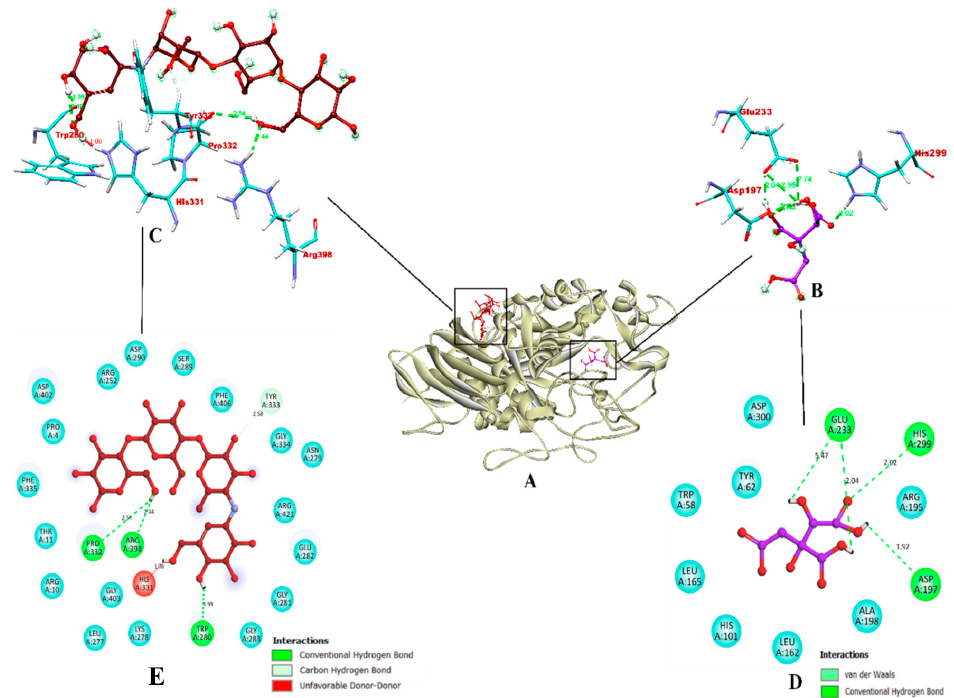
Figure 9. The binding interactions of hydroxyacetic acid and acarbose within the inhibitor binding site of target protein α -amylase. ( A ) Ribbon representation of a protein model bound with the ligands (inside the binding site); ( B , C ) Three-dimensional binding pattern of hydroxyacetic acid and acarbose, respectively. ( D , E ) Two-dimensional binding pattern of hydroxyacetic acid and acarbose, respectively. Red: acarbose; purple: hydroxyacetic acid. Blue: surrounding residues; colored: bound